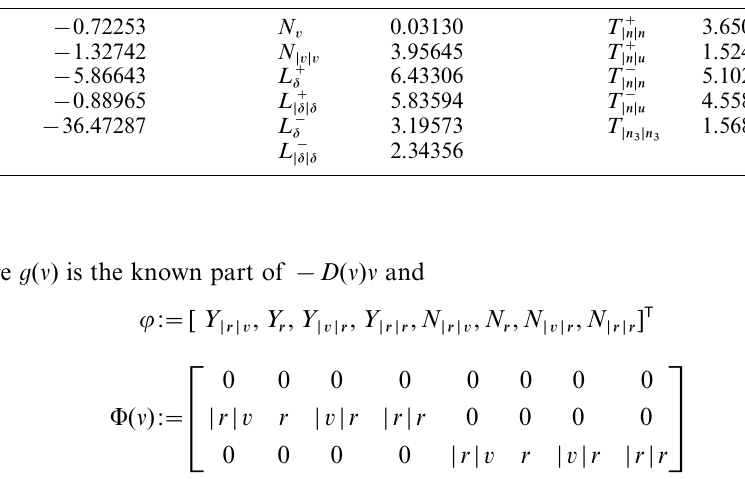
Table 2. Experimentally identified parameters for CyberShip